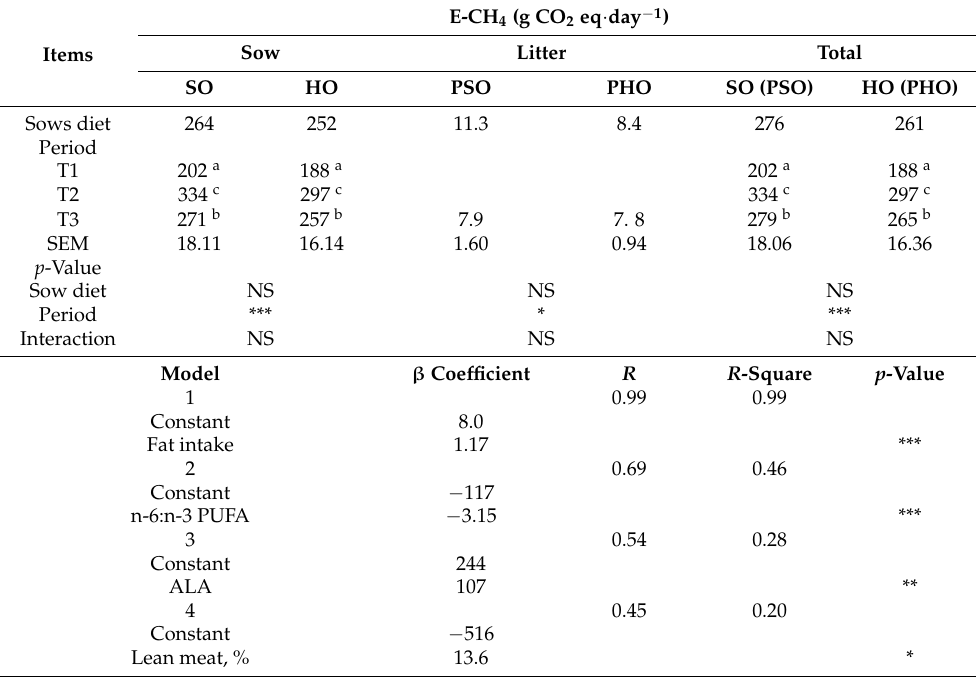
Abbreviations: standard error of the mean, SEM. We took into account the global warming potential of 25 for CH 4 . a Dependent variable, E-CH 4 and its potential predictors. T1 = 12 h after farrowing, T2 = 10 days, T3 = 21 days; NS: nonsignificant effect; * p < 0.05 (significant difference between means); ** p < 0.01 and *** p ≤ 0.001 (highly significant difference between means). a,b,c Different superscript letters indicate significantly different means ( p <